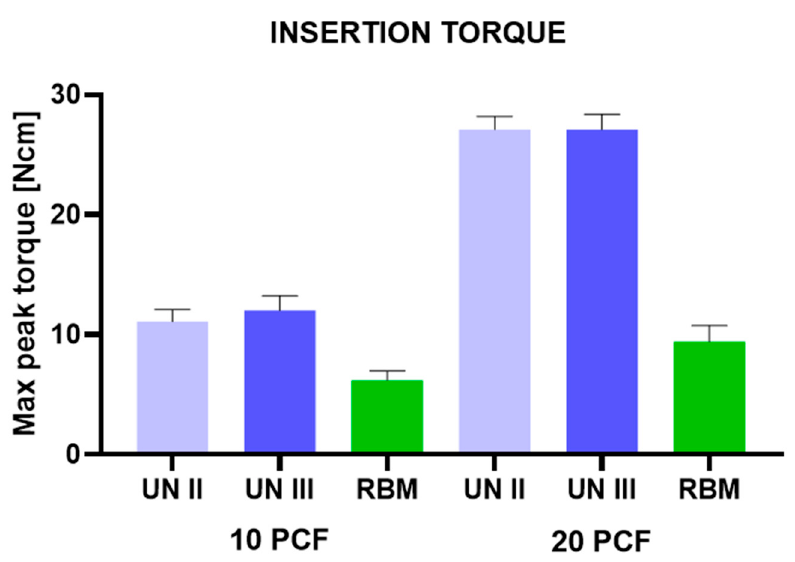
Figure 4. Insertion torque of UN II, UN III, and RBM implants in polyurethane foam blocks (10 pcf; 20 pcf). Table 1. Summary of the insertion torque values of the different experimental Groups.